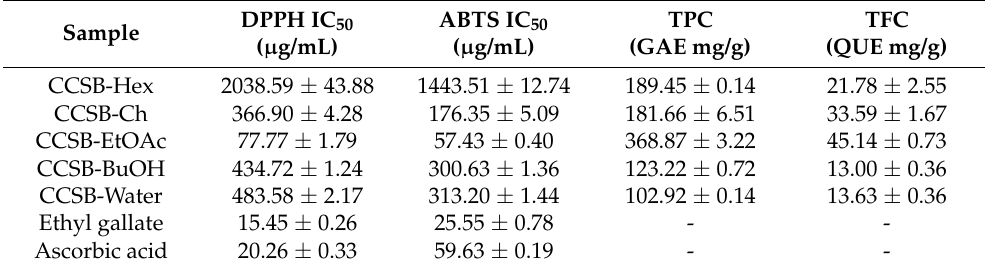
Figure 3. ( A ) DPPH free radical scavenging activities and ( B ) ABTS cation radical scavenging activities of extract and solvent fractions from C. cuspidata var. sieboldii branch (CCSB). Table 1. Antioxidant effect and total polyphenol and total flavonoid content results of CCSB.